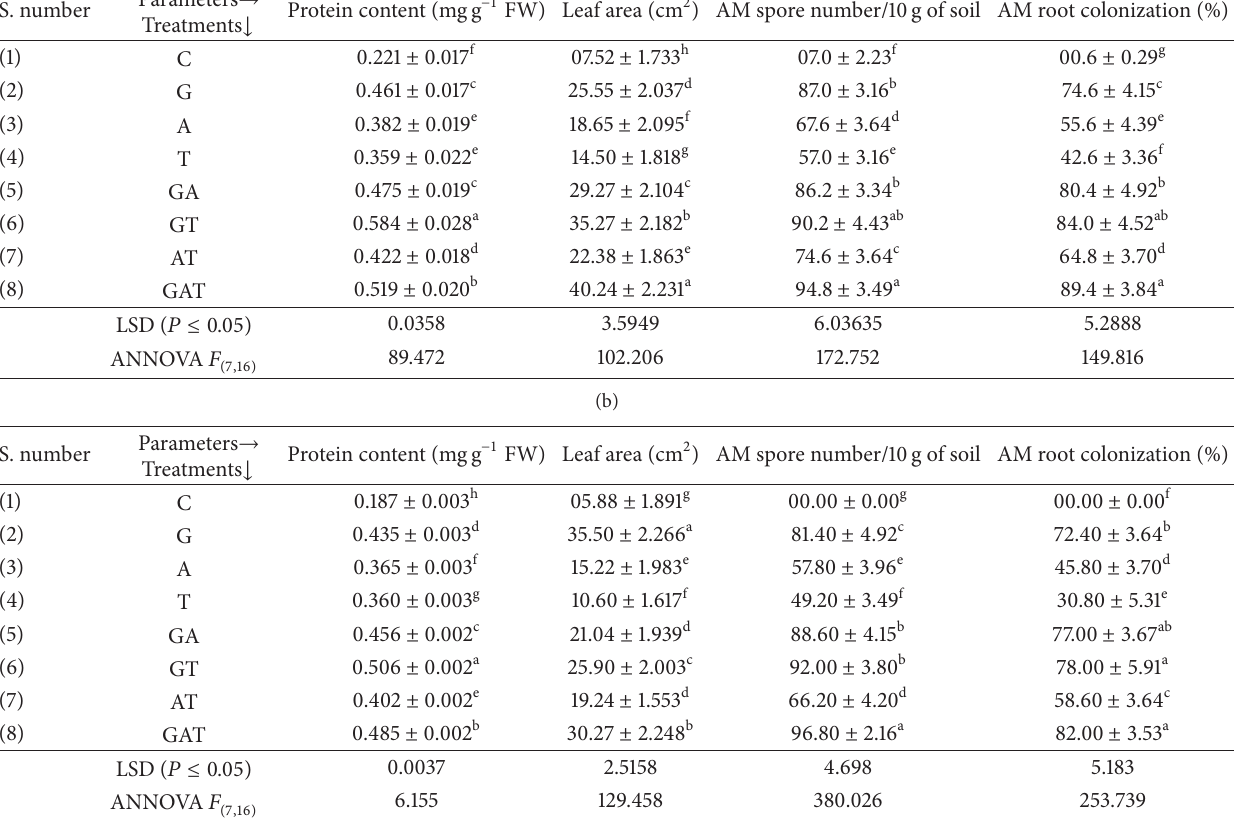
Table 2: (a) Interactive effect of AM fungi and T. viride on protein content, leaf area, and mycorrhization in Phaseolus mungo var. UH-1 after 120 days of inoculation. (b) Interactive effect of AM fungi and T. viride on protein content, leaf area, and mycorrhization of Phaseolus mungo var. IPU-94-1 after 120 days of